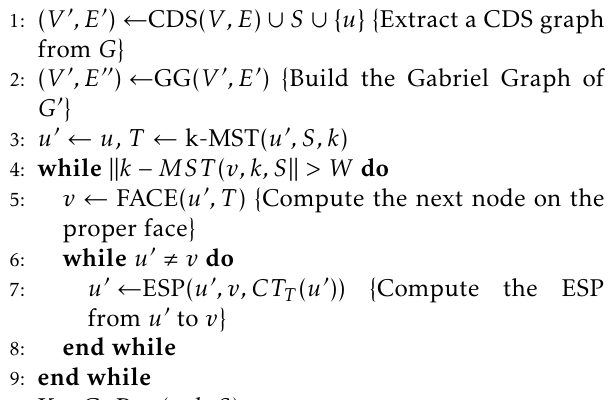
Algorithm 2 RECOVERY(u,k,S,W) - Run at node u .